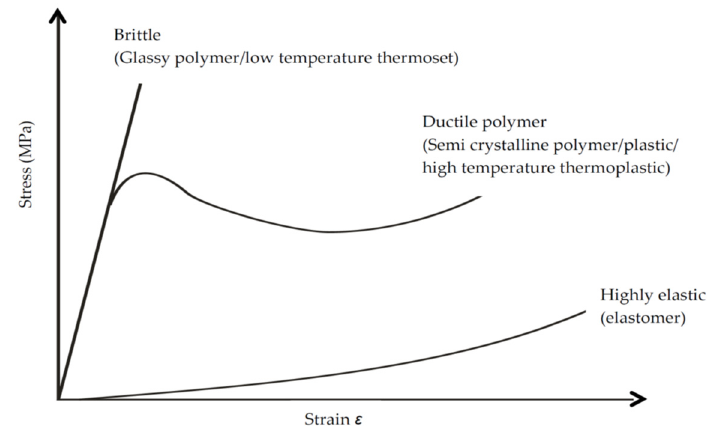
Figure 6. Stress–strain curves of various polymeric materials. Adapted from [77].